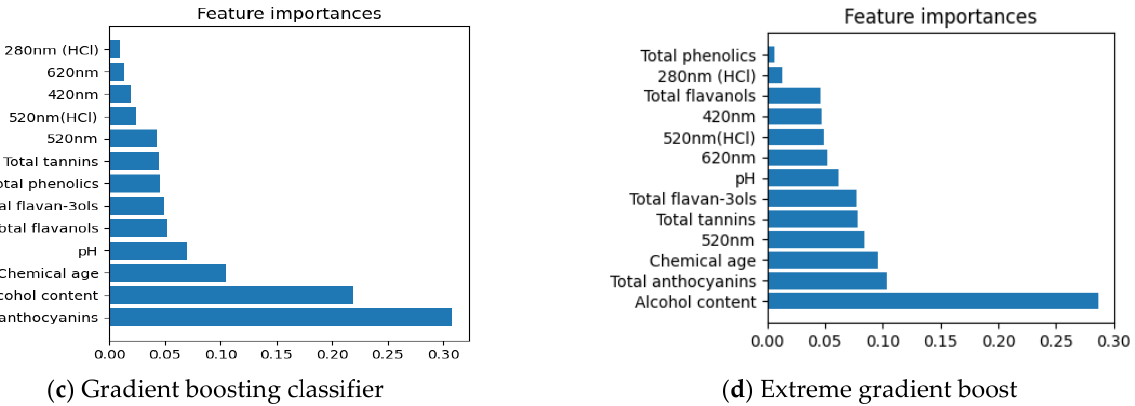
Figure 4. Features selection of 13 chemical data using Random forest, Extra trees classifier, Gradient boosting classifier, and Extreme gradient boost in vintages (old/new vintages). ( a – d ) display the important chemical parameters in Vintage Points that are selected by Random Forest, Extra trees classifier, Gradient boosting classifier and Extreme gradient boost, respectively.